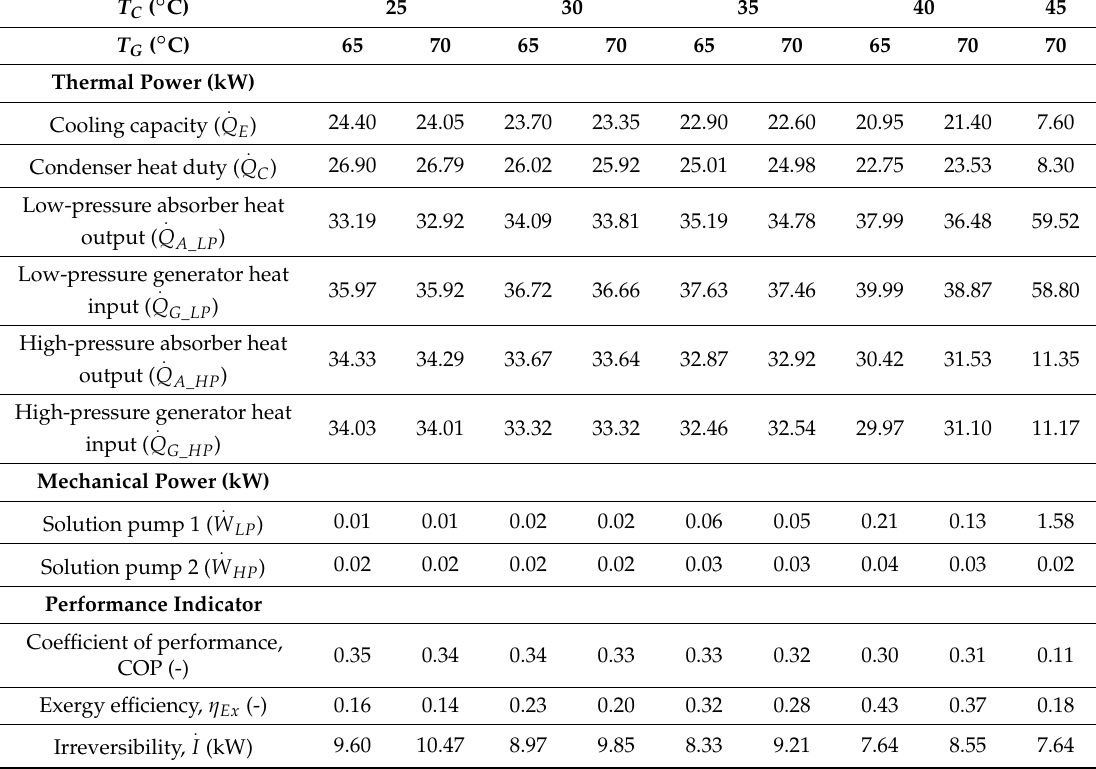
Table 6. Performance summary of the modeling of well W-LV5 coupled to a half-effect cooling system. Case study: Air conditioning ( T E = 10, PF =